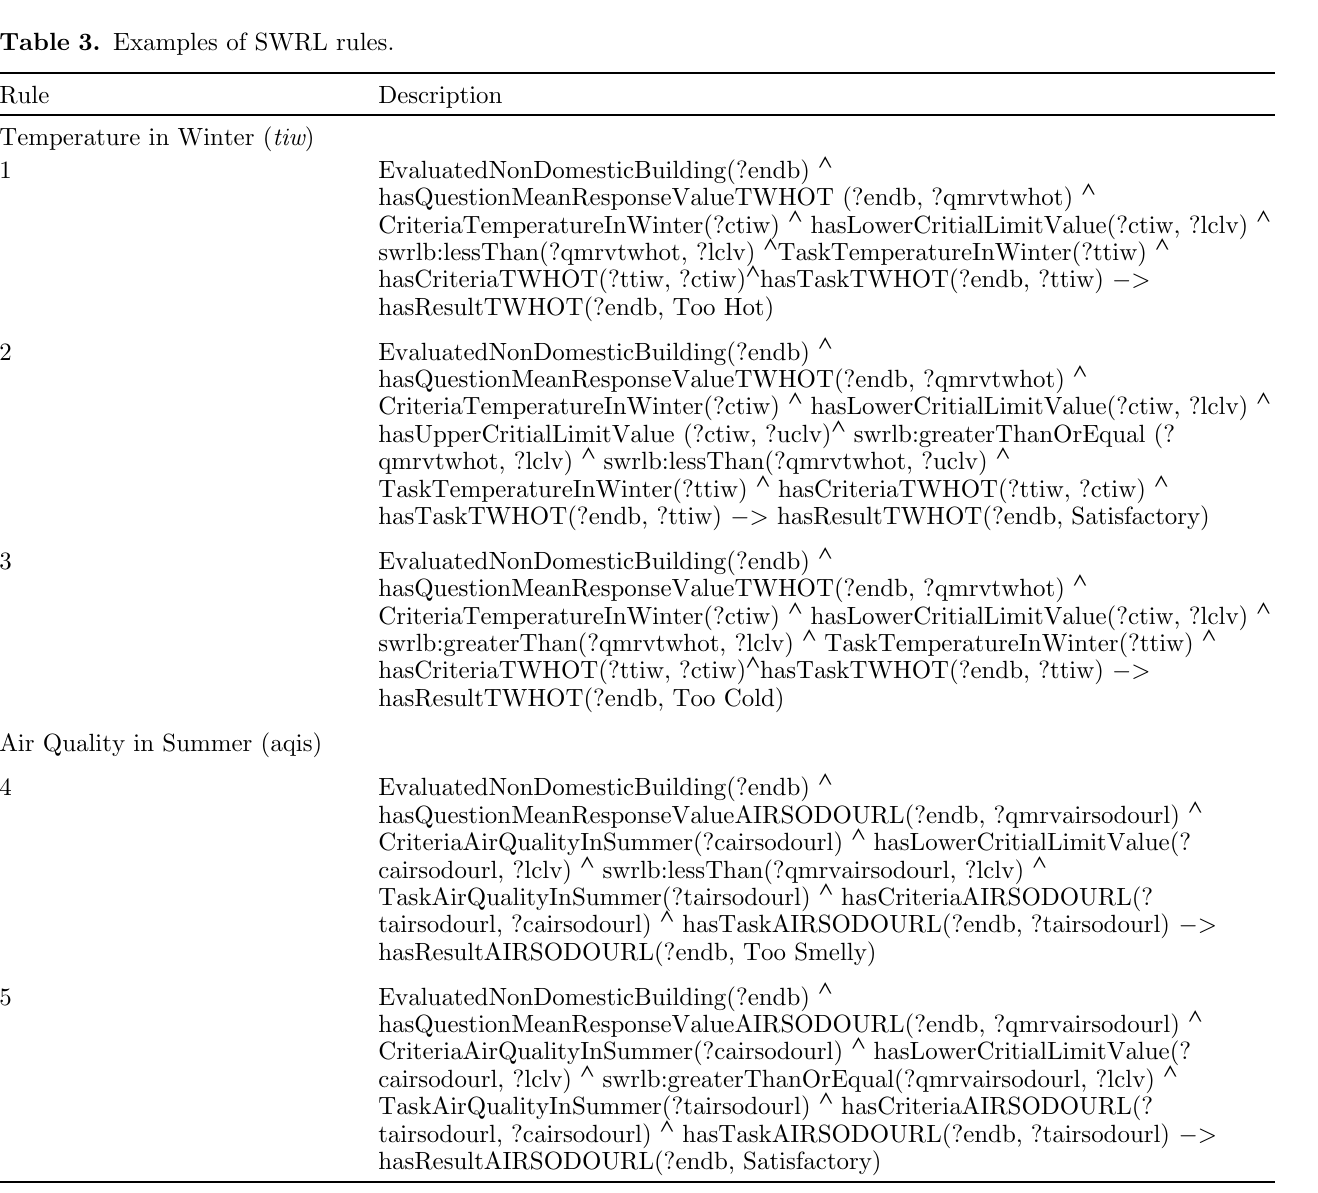
Table 3. Examples of SWRL